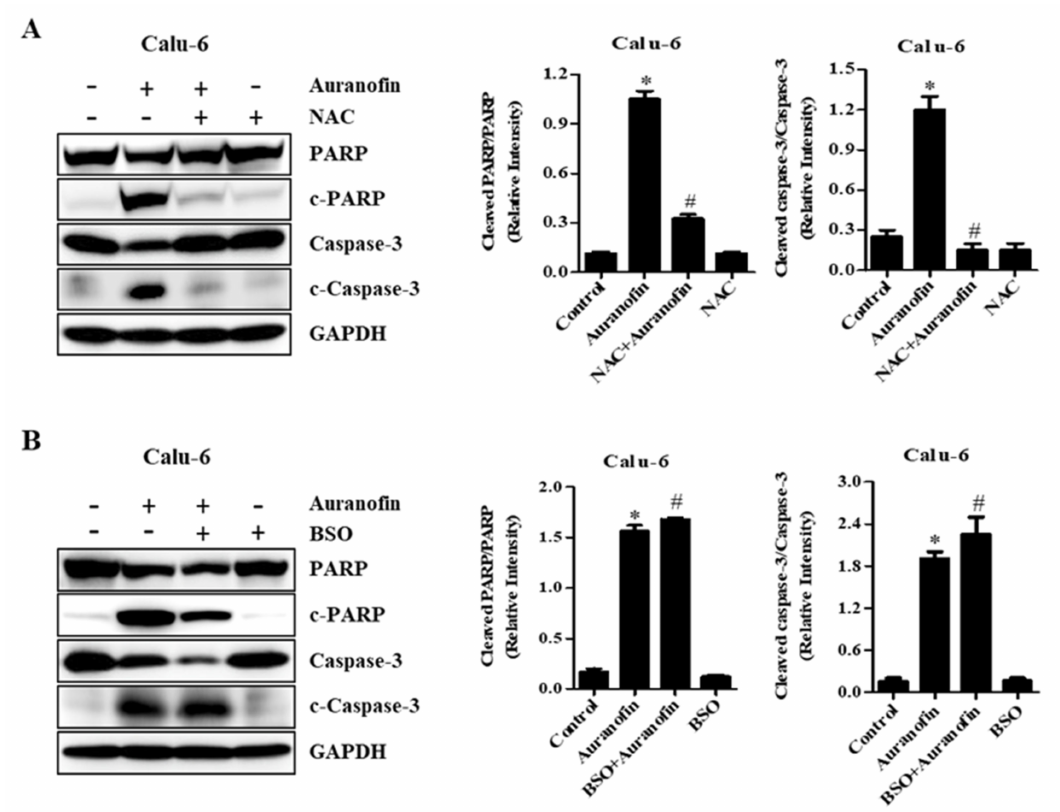
Figure 6. Effects of NAC and BSO on apoptosis-related protein levels in auranofin-treated Calu-6 cells. Exponentially growing Calu-6 cells were incubated in the presence of 3 µ M auranofin for 24 h following 1 h preincubation with 2 mM NAC or 10 µ M BSO. Whole-cell extracts were prepared, and equal amounts of lysates were then resolved through SDS-PAGE, transferred onto PVDF membranes, and immunoblotted with the indicated antibodies against PARP, cleaved PARP, procaspase-3, cleaved caspase-3, and GAPDH (A and B). GAPDH detection was used to confirm equal protein loading. Graphs show ratio of cleaved PARP/PARP and cleaved caspase-3/caspase-3 in auranofin-treated cells, and band intensities were quantified using the Image J program ( A , B ). * p < 0.05 compared with auranofin-untreated control cells. # p < 0.05 compared with cells treated with auranofin